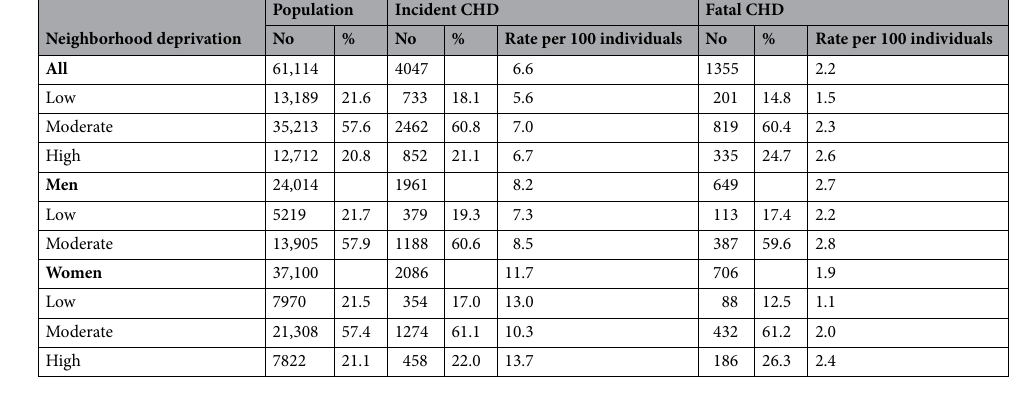
Table 1. Distribution of population, number of cases, and cumulative rates of incident and fatal CHD of patients with bipolar disorder, 1997–2017. CHD Coronary heart